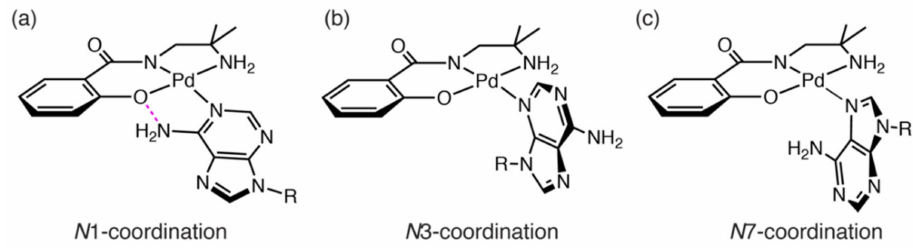
Figure 9. Three possible coordination modes for Pd-A (R indicates the ribose moiety). ( a ) N 1-coordination mode, ( b ) N 3-coordination mode, and ( c ) N 7-coordination mode. Hydrogen bonds are shown in magenta.